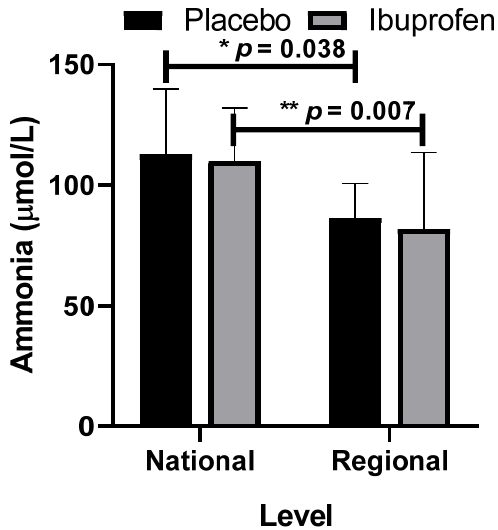
Figure 7. Ammonia with the use of placebo (PLA) and ibuprofen (IBU) at different training levels. Regarding the results, “*” indicates a difference between the regional and national levels with the use of placebo ( p = 0.038) and “**” with the use of ibuprofen ( p = 0.007, F = 11.937, η 2p = 0.570, very high effect).